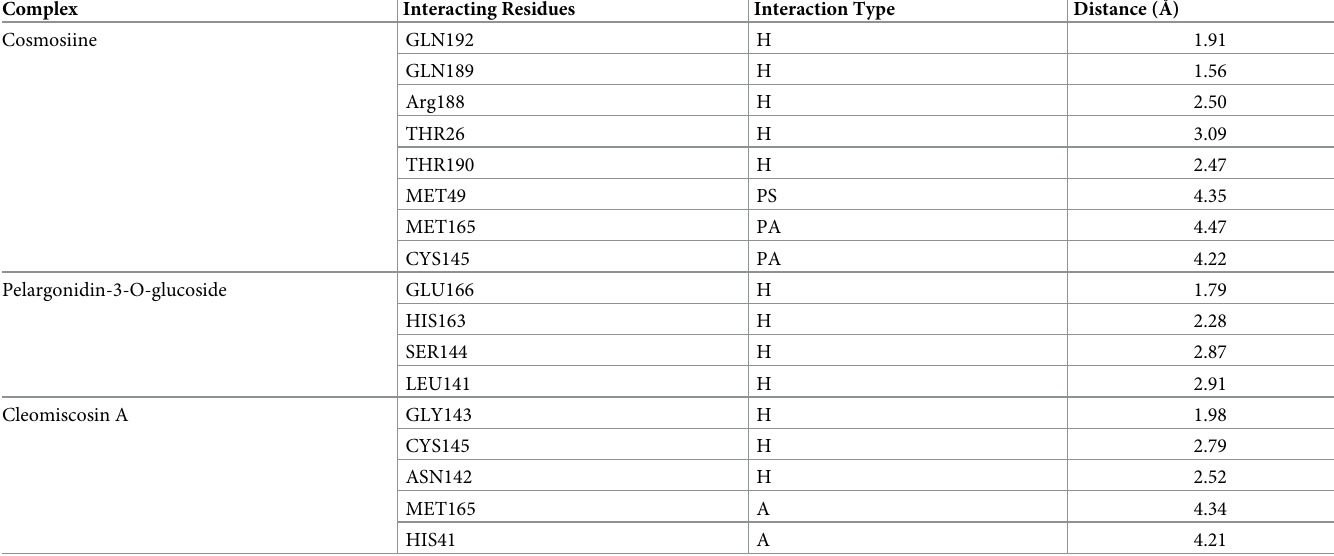
Table 4. Non-bonded interactions of the docked complexes after the 100-ns simulation time, where H, PS, PA, and A represent hydrogen, pi-sulfur, pi-alkyl, and alkyl bonds, respectively.